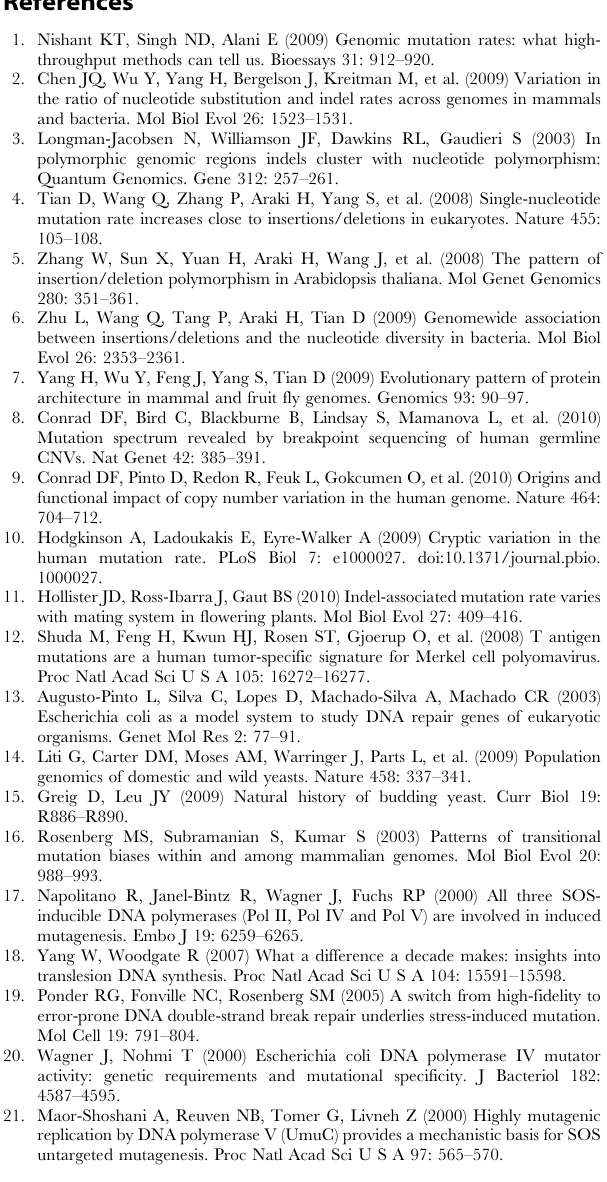
Table S6 Bacterial strains and analysed results used for Figure S4. The original data were from